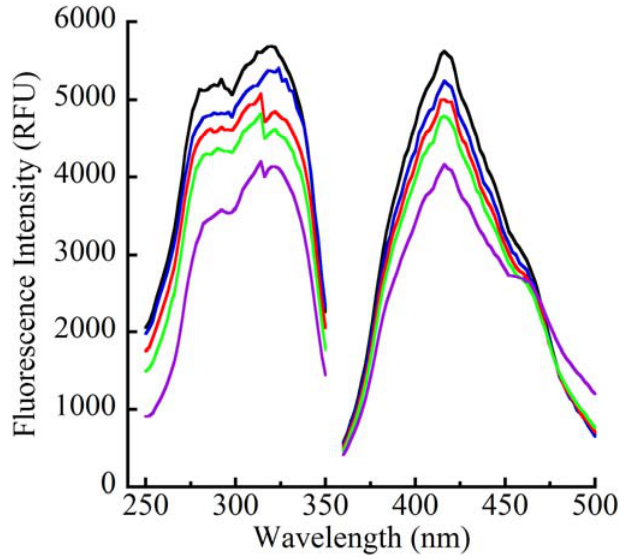
Figure 4. Excitation and emission spectra of laccase-oxidized CA. Increasing concentrations of laccase were reacted with 250  M CA in 100  L of citrate buffer, pH 4.5. Reactions were carried out in 96-well UV-transparent microplate and stopped at 30 min through the addition of 250 mM KOH. The pH 4.5 reactions were cloudy due to the formation of DHPs. The cloudiness disappeared upon basification yielding clear solutions that were scanned over the excitation wavelengths of 250 to 350 nm in 2 nm intervals (  em, 416 nm) (left panel). The black tracing with the highest fluorescence is the excitation spectrum of 250  M unmodified CA. The profiles with decreasing fluorescence intensities represent the excitation spectra of CA oxidized by 0.01 (blue), 0.05 (red), 0.1 (green) and 0.25 (purple)  g/mL laccase. Samples were then excited using 310 nm wavelength and the emission was scanned between 360 and 500 nm in 2 nm intervals (right panel). The black tracing with the highest fluorescence intensity is the emission spectrum of 250  M unmodified CA. The tracings with progressively declining fluorescence intensities represent the emission spectra of CA oxidized using 0.01 (blue), 0.05 (red), 0.1 (green) and 0.25 (purple)  g/mL